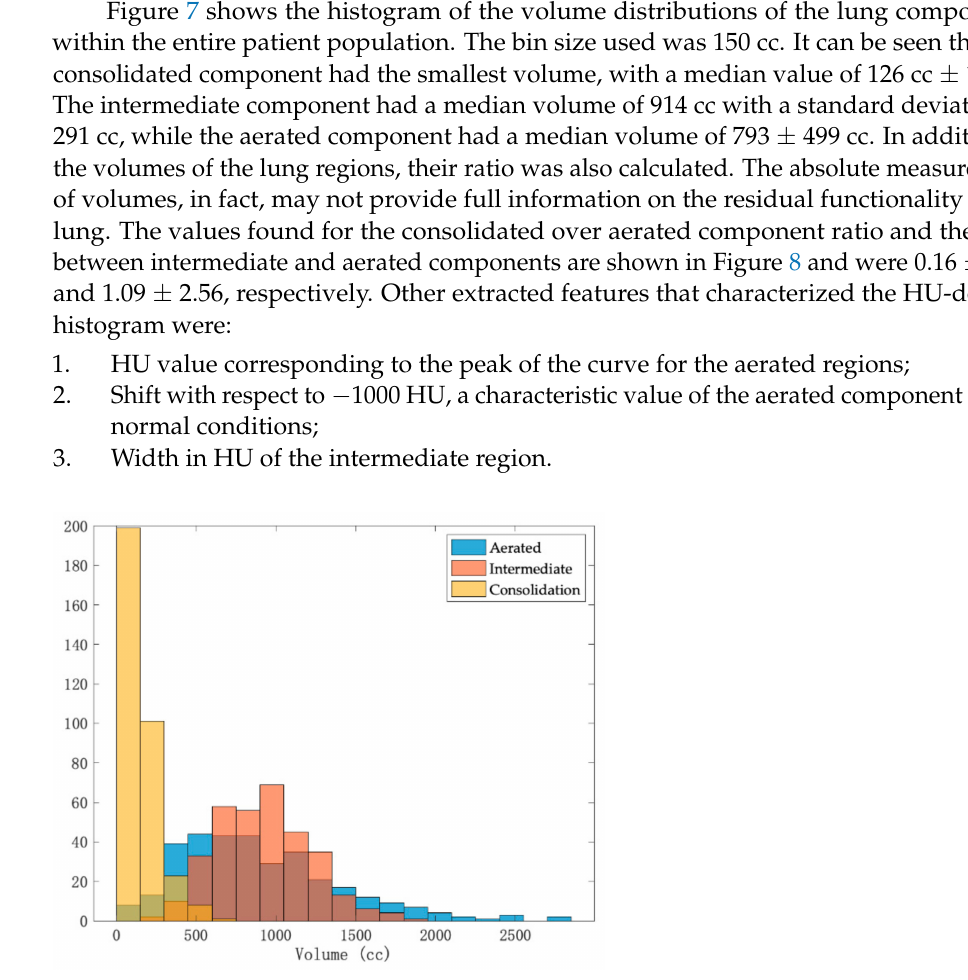
Figure 7. Histogram of the volume distributions of the aerated, intermediate, and consolidated components. The bin size used was 150 cc. The number on the y-axis represents the number of patients per bin.